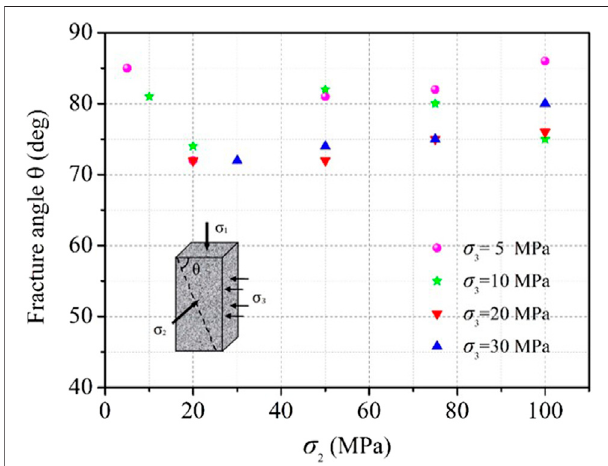
FIGURE 10 | Fracture angles of tested granite change with σ 2 under different σ 3 stress states.